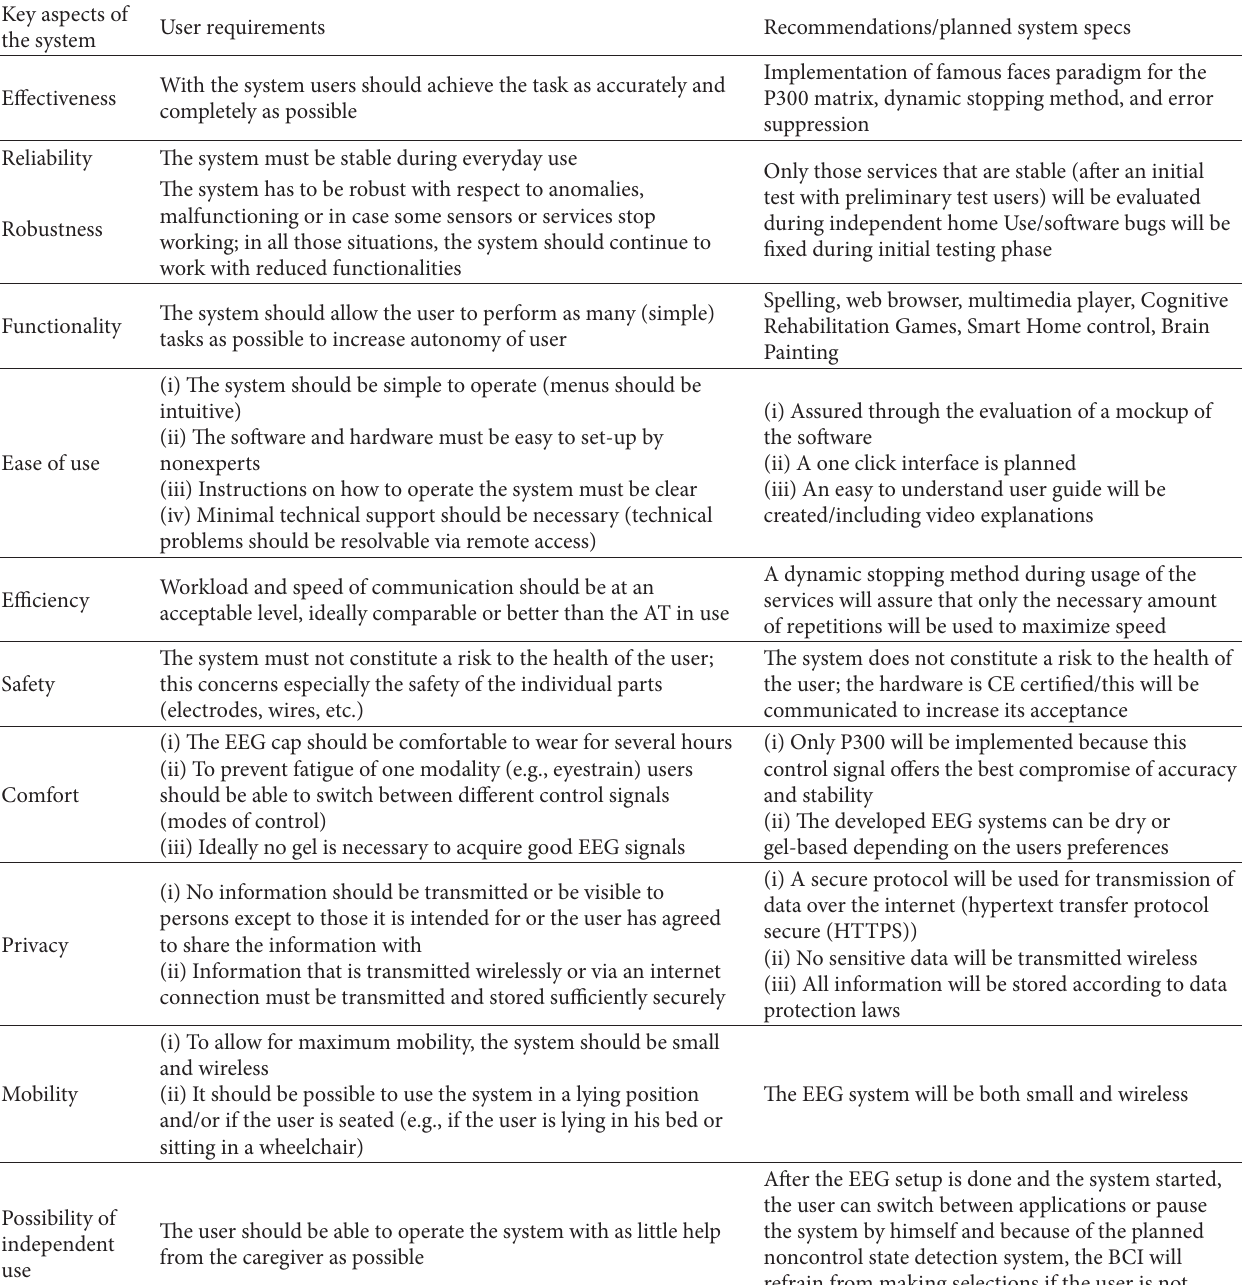
Table 1: Recommendations from users in order of